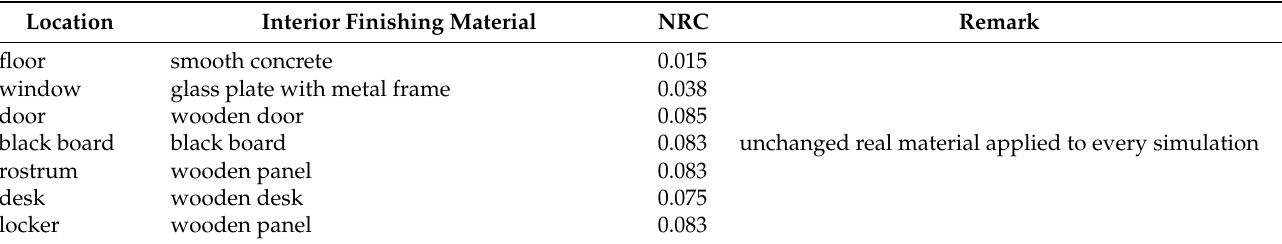
Table 4. Sound absorbing coefficient (NRC) for computer